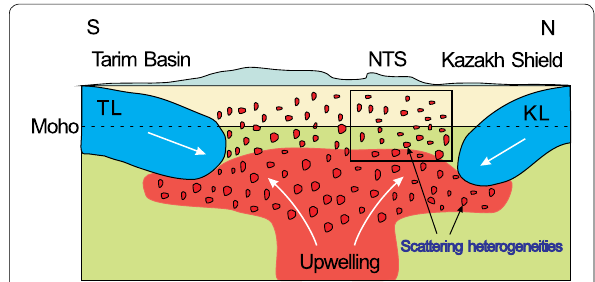
Fig. 13 A cartoon illustrating the small-scale melt pockets (small red patches) supplied from upwelling mantle materials beneath the northern Tien Shan (NTS). These melt pockets represent the scattering heterogeneities responsible for the fluctuating P-wave coda. The rectangle approximately denotes the scattering regions of interest beneath the study area. TL indicates the Tarim lithosphere and KL indicates the Kazakh